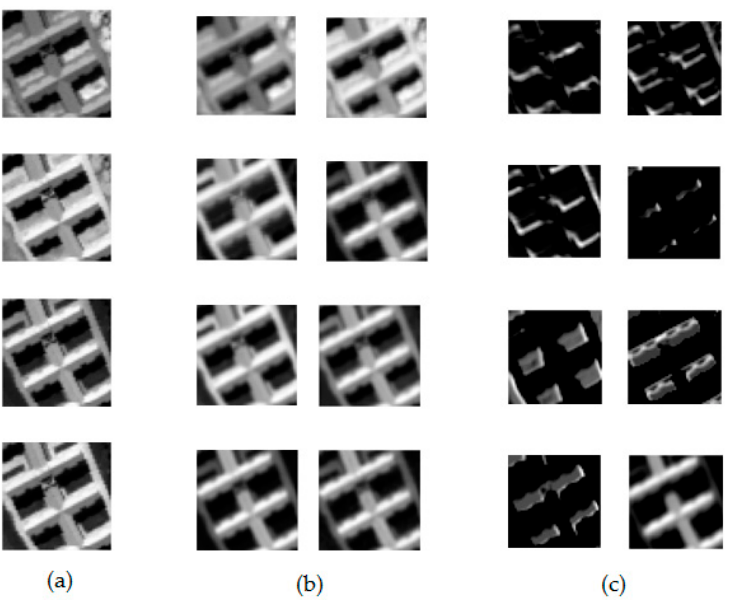
Figure 3. ( a ) Input HSI. ( b ) Feature images extracted from C1. ( c ) Feature images extracted from C2.